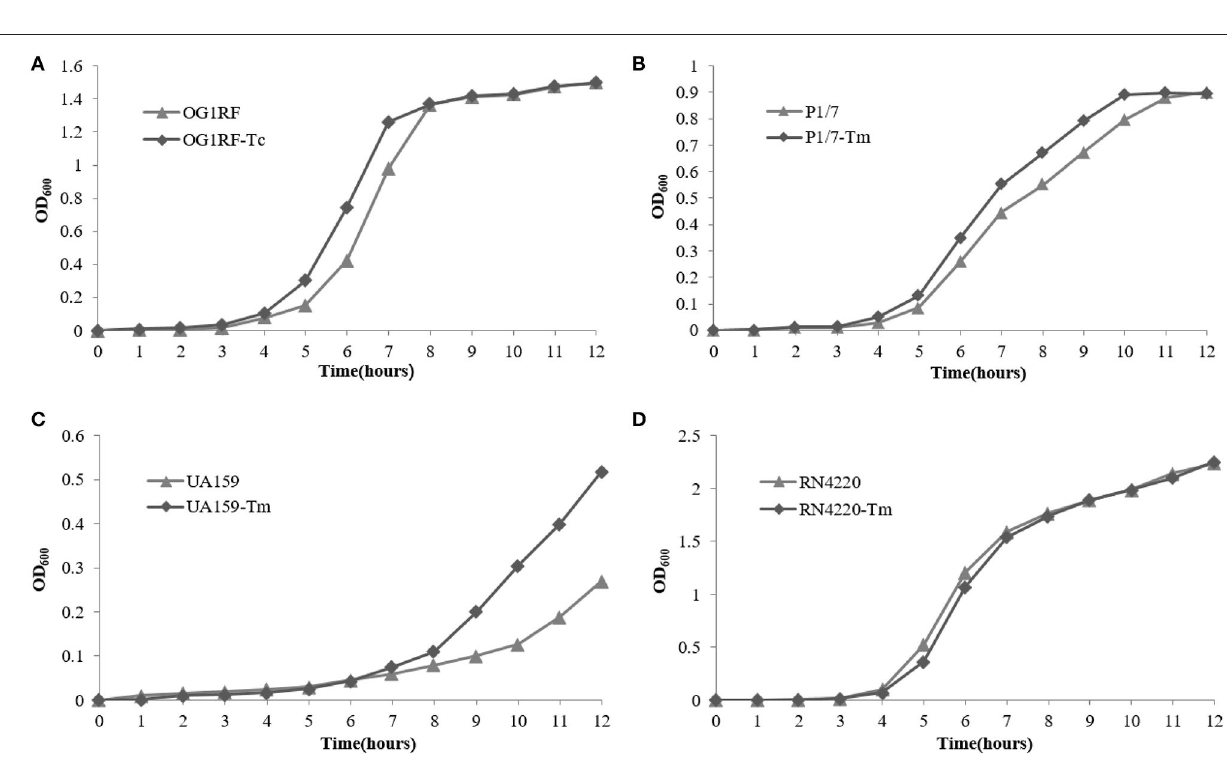
and a higher clindamycin MIC (32 mg/L) compared with